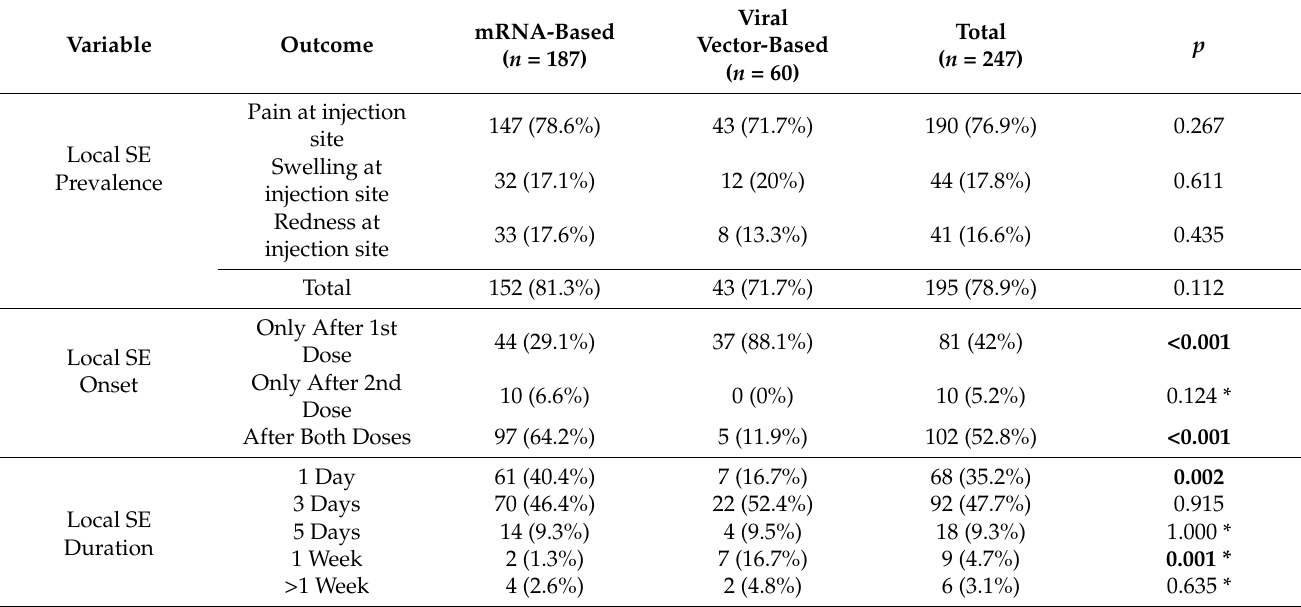
Table 4. Local adverse effects of COVID-19 vaccines reported by Polish healthcare workers.